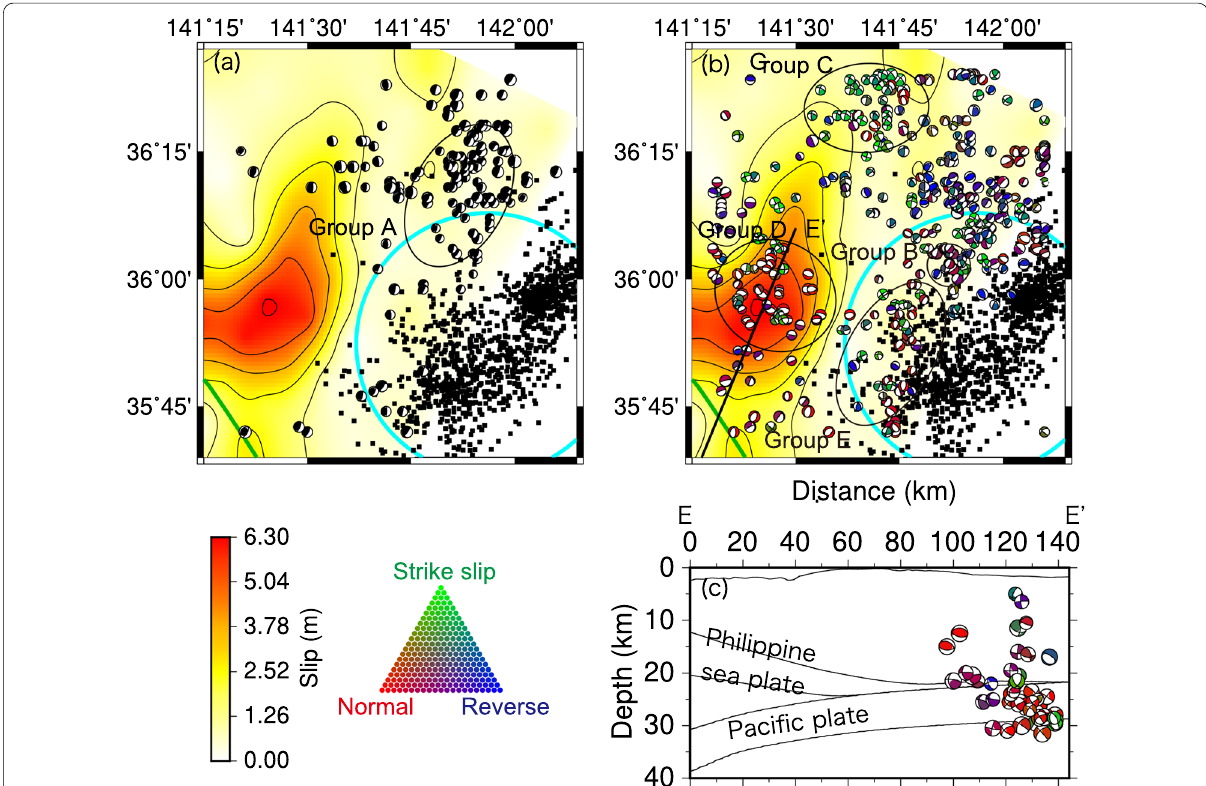
Fig. 8 a Spatial distribution of the thrust mechanisms. The black squares show the tectonic tremors detected by Nishikawa et al. (2019). The slip area of the 2011 Ibaraki-oki earthquake (Kubo et al. 2013) is also shown. The cyan circle shows the subducting seamount (Mochizuki et al. 2008). The green line shows the northeastern limit of the Philippine Sea Plate (Uchida et al. 2010). b Spatial distribution of the non-thrust mechanisms. The color of the focal mechanisms shows their type: red mechanisms are normal faults, blue mechanisms are reverse faults, and green mechanisms are strike-slip faults. c Cross section of the E–E’ line, in which the point E is at 140.9 ◦ E and 34.9 ◦